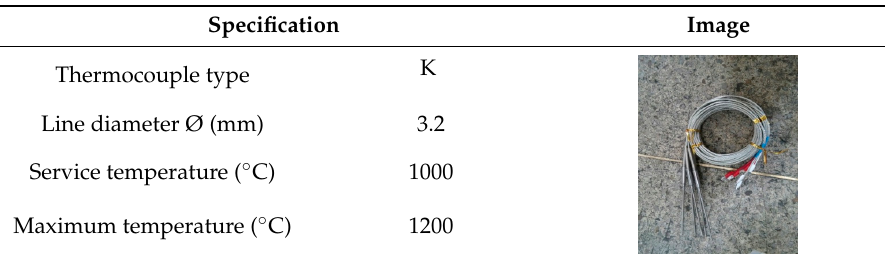
( b ) Figure 3. Installation of sensor and controller in the factory: ( a ) thermocouple sensor attached to the mold; ( b )